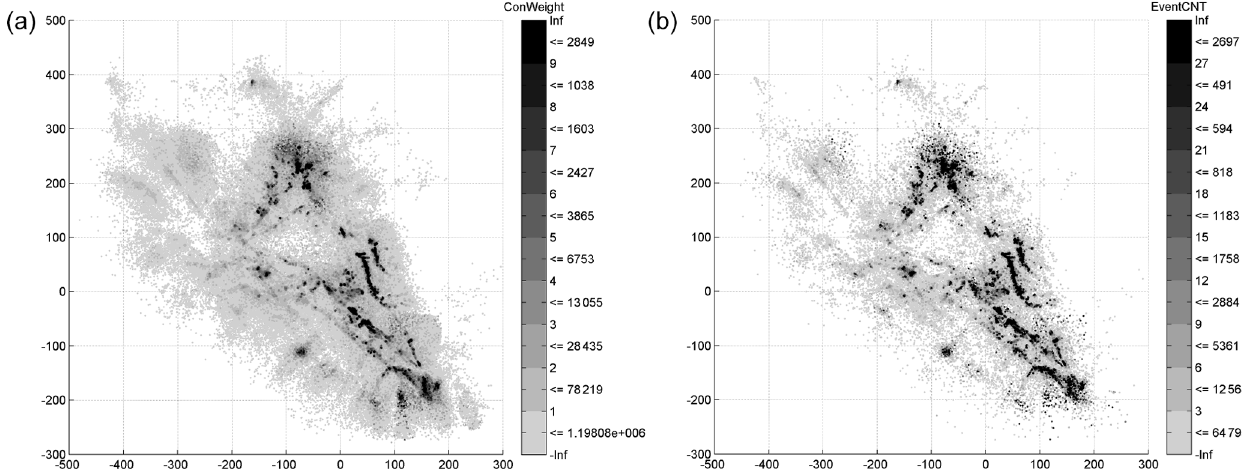
Figure 10. (a) Mean locations of condensed 600463 Gaussian components shaded according to their weights. (b) The same components shaded according to the total number of events assigned to them after the maximum likelihood